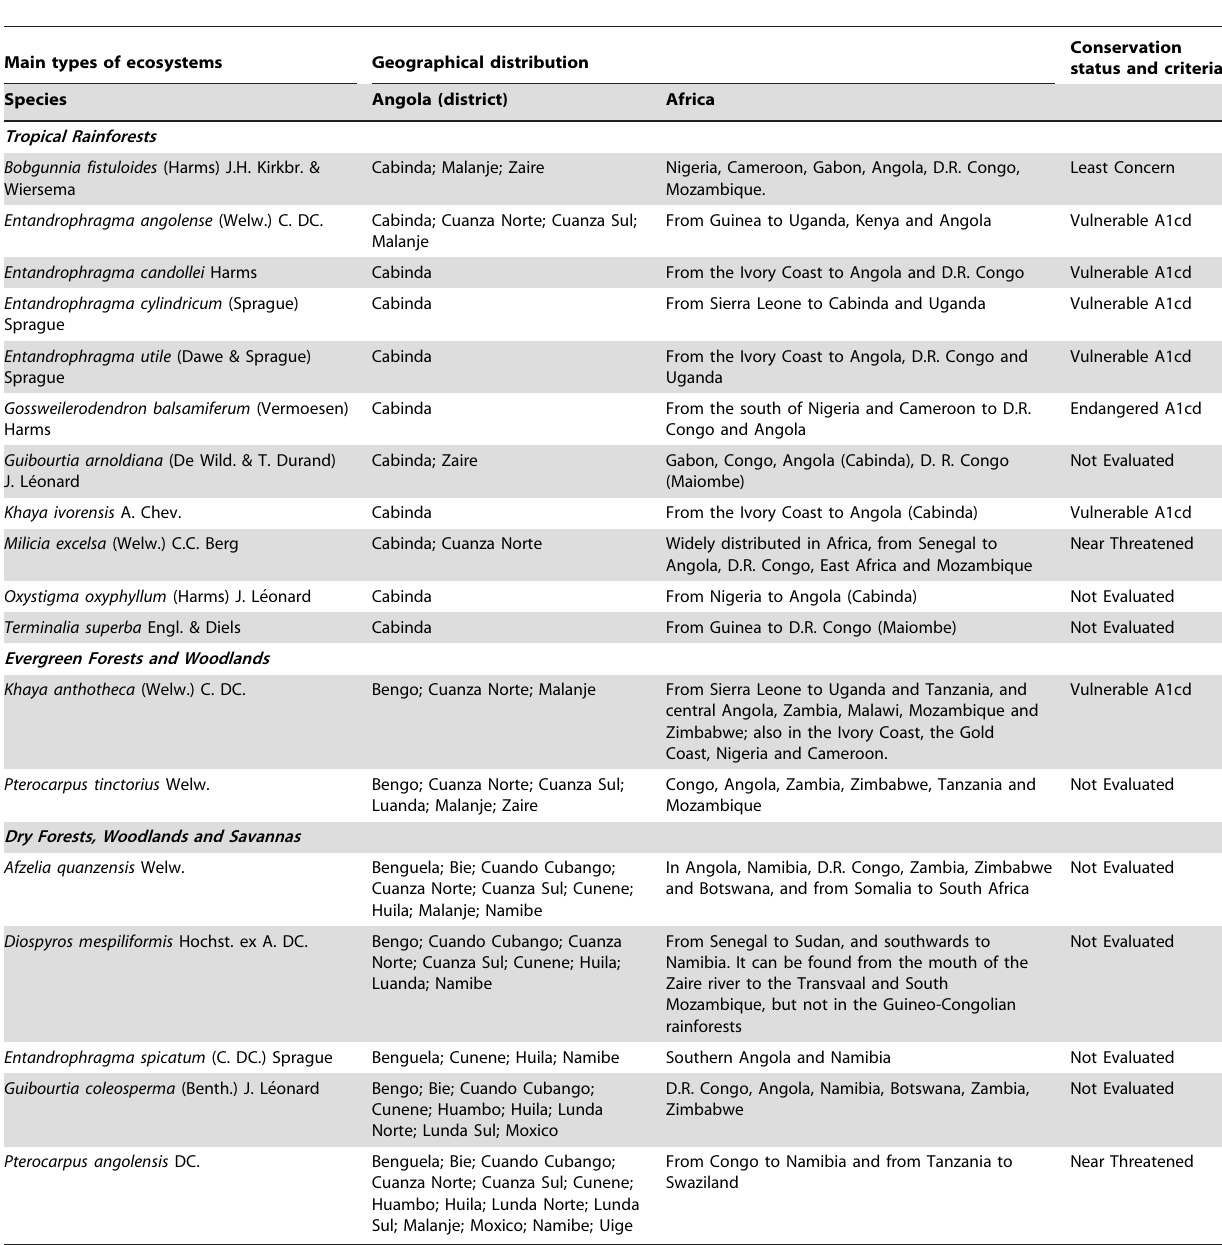
Table 1. Geographical distribution in Angola and in the African continent, main types of ecosystems and global conservation status [45] for each species considered in the present study. Nomenclature according to The Plant List